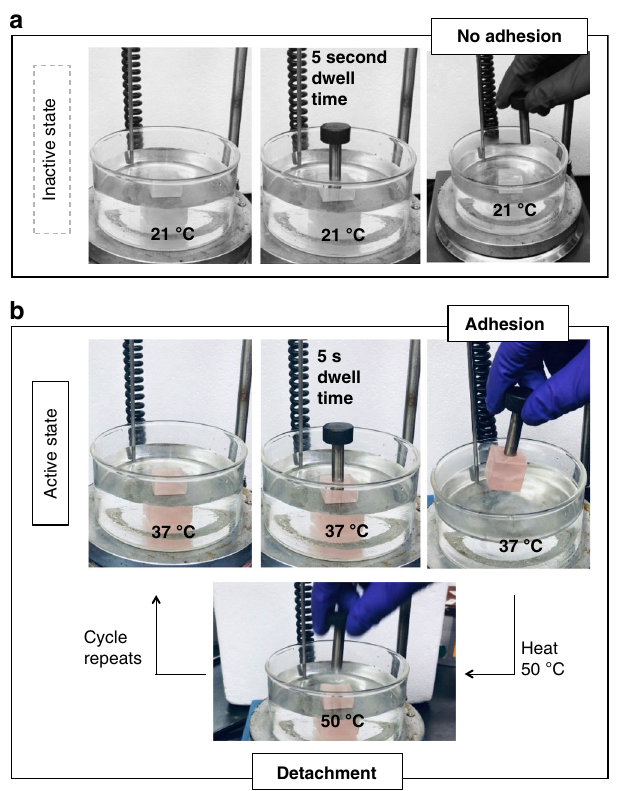
Fig. 4 Adhesive system with thermoresponsive bonding and debonding. a Glass cube (20 g) coated with PPGBC-56 in DI water with a steel rod (35 g, 50.3 mm 2 surface area) placed on top. At 21 °C, the adhesive is not able to bond to the rod and the adhesive system is inactive. b At 37 °C, there is suf fi cient bonding to pick up the glass cube. At 50 °C, the adhesive weakens and detachment of the cube from the rod occurs. Lowering the temperature to 37 °C repeats the bonding/debonding cycle. Lowering the temperature further to 21 °C returns the system to the inactive elastic pro fi le (Fig. 3e, f), PPGBC-56 wets and strongly adheres to the probe ’ s surface with minimal applied force (i.e., essentially independent of applied force). An applied axial force of 0.5 N requires 32.1 ± 2.3 N of force to separate the materials. Increasing the applied force to 1, 5, and 20 N does not change the peak force, the S tack force increases to 37.0 ± 2.51 N, although bearing no statistical signi fi cance.